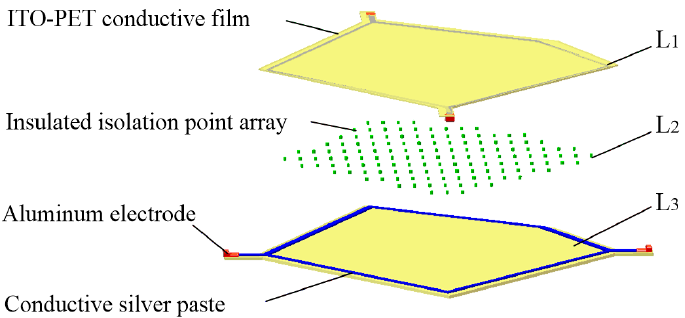
Figure 12. Structural model of tactile sensor.